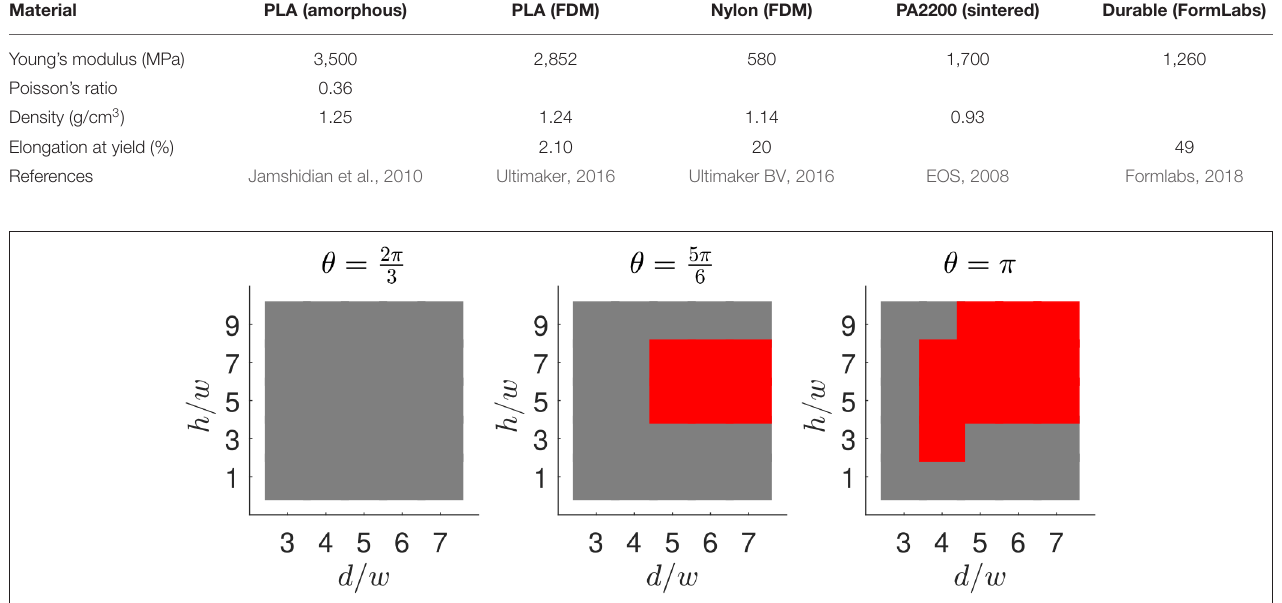
FIGURE 5 | A total of 75 FE simulations were used to plot the colormaps. Red indicates bistability and gray monostability. The dimensions not appearing above were a 170 mm and w 1 mm. = =